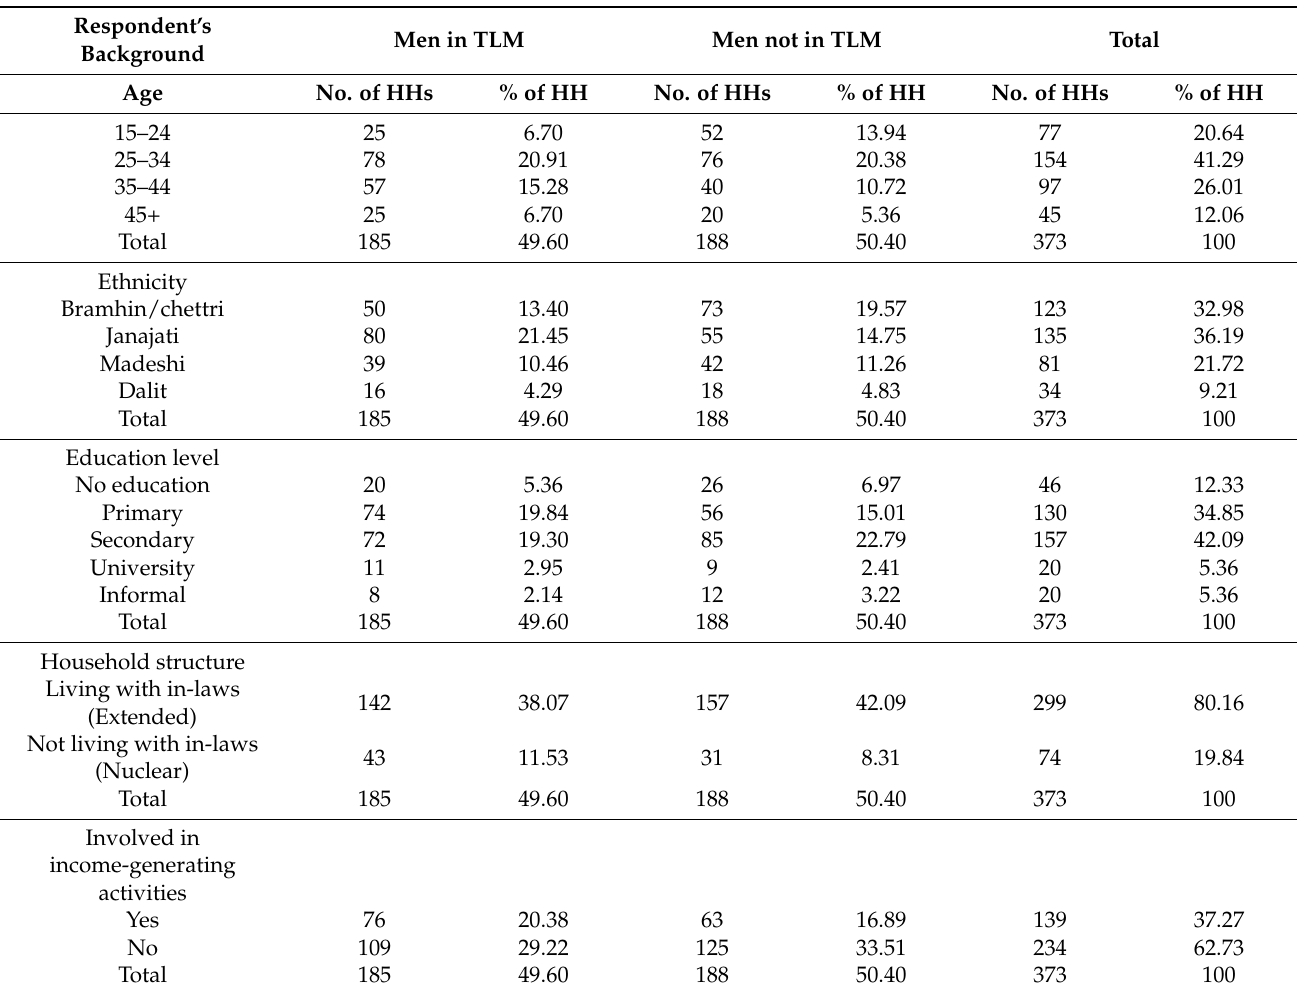
Table 2. Descriptive characteristics of the